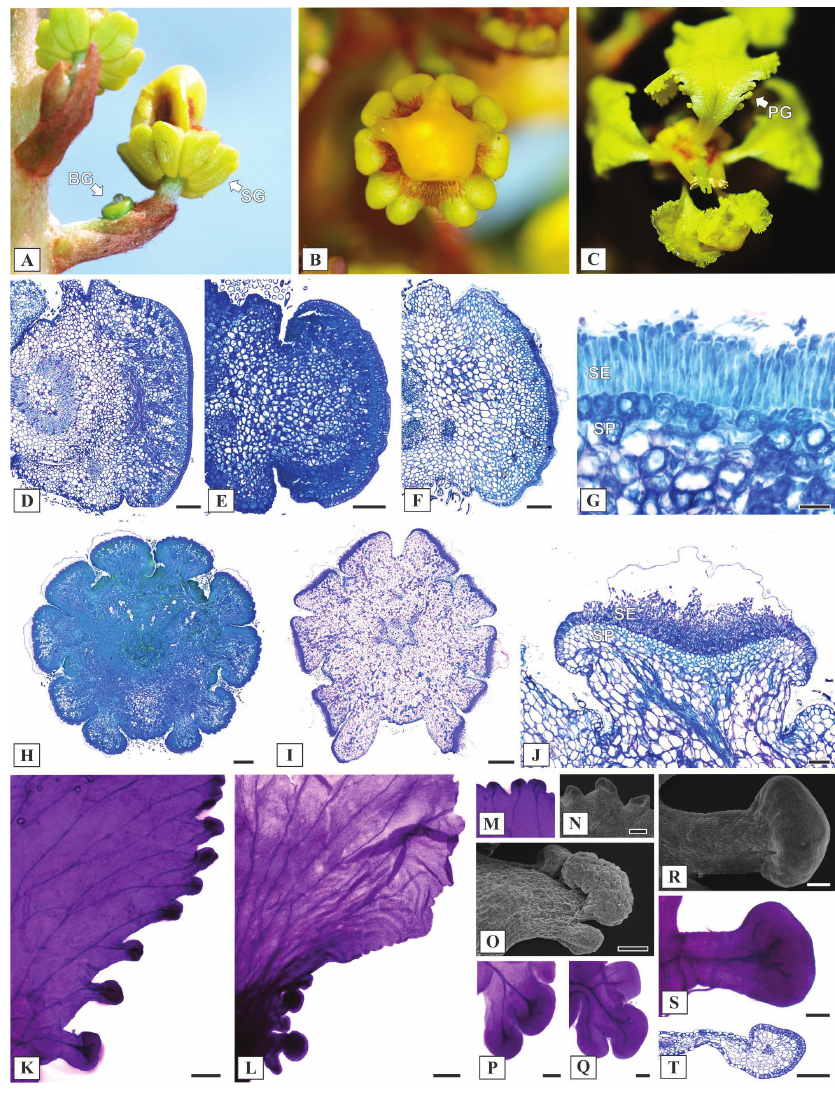
Figure 4. Reproductive morphoanatomy of Mcvaughia species. A inflorescence during development, showing a bracteole gland (BG) and Sepal glands (SG) B ten sepal glands encircling the calyx C Petal glands (PG) along the margin of posterior petal D–F transverse section of bracteole glands in M. sergipana , M. bahiana and M. piauhiensis , respectively G anatomical arrangement of bracteole gland, with a palisade-like secretory epidermis (SE) and secretory parenchyma (SP) H–I transverse section of floral bud and anthesis flower in Mcvaughia bahiana and M. sergipana ; calyx gland pair displaced at the anterior sepal J calyx gland structure, showing a secretory epidermis (SE) and vascularized secretory parenchyma (SP) K–L petal glands on the margin of petals in M. sergipana and M. bahiana respectively M–N detail of the petal glands at the apex of the petal limb in M. sergipana , cleared and in SEM image O–Q petal glands positioned at the base, M. bahiana on SEM image, M. bahiana and M. piauhiensis cleared R–T conspicuous and stalked petal glands at the base of M. sergipana , in SEM image, cleared and longitudinal section. Scale bars: 200 μm ( D ), 150 μm ( E–F ), 50 μm ( G ), 500 μm ( H–I ), 100 μm ( J, P–S ), 300 μm ( L–M ), 200 μm ( N, T